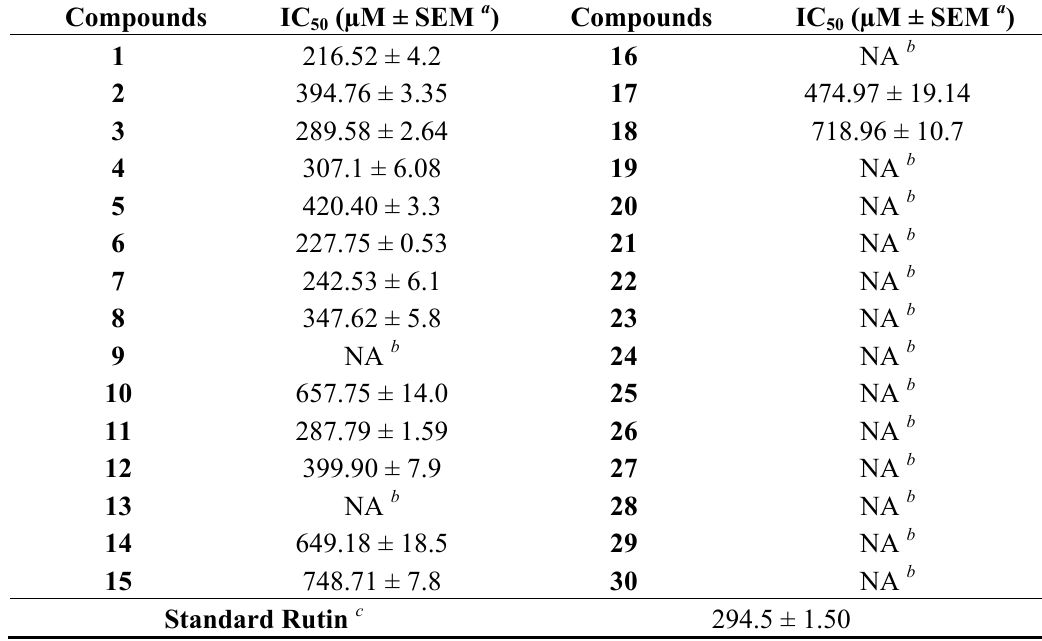
Table 1. In vitro protein glycation inhibitory activity of compounds 1 – 30 .